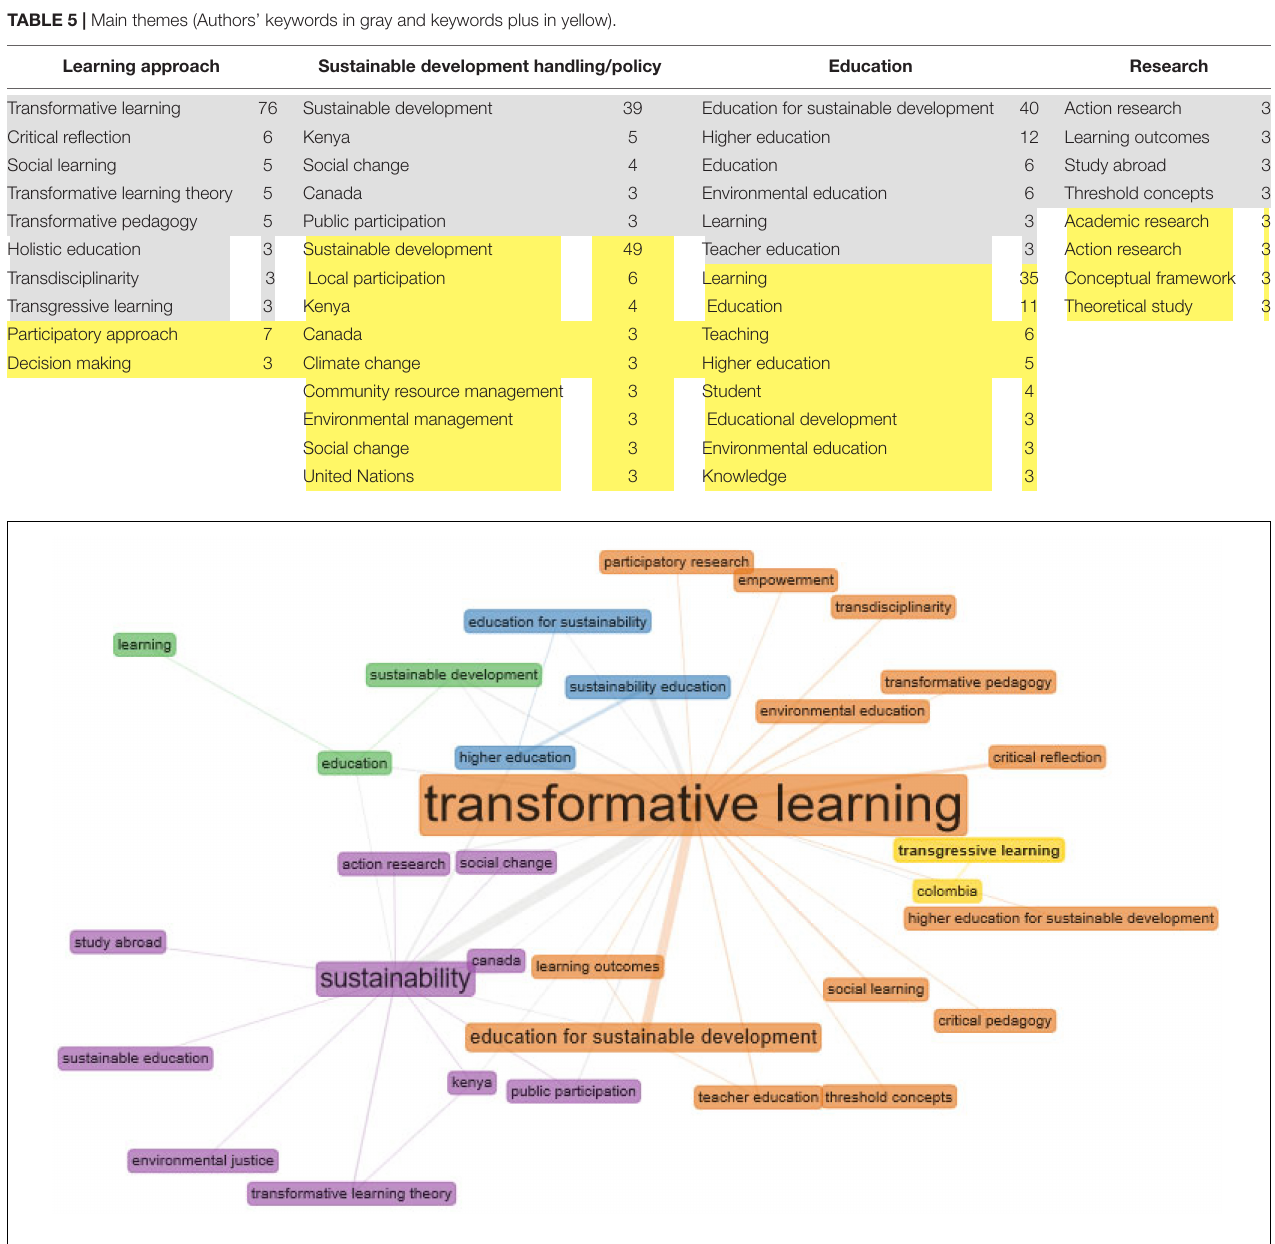
FIGURE 8 | Keyword network grouped according to cluster